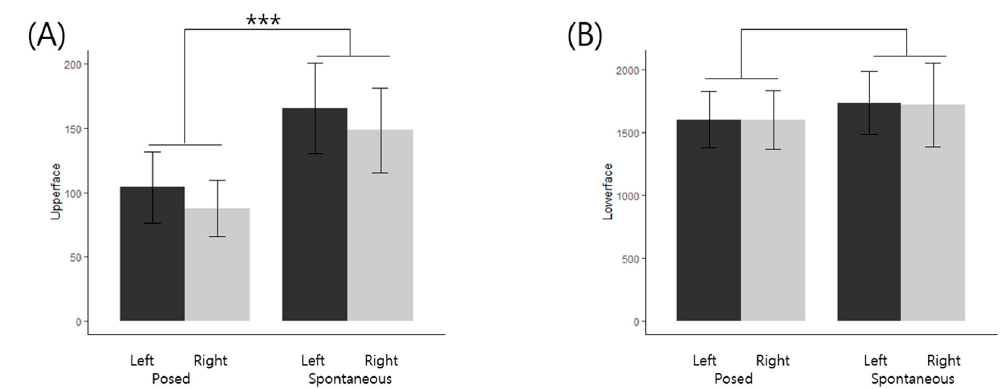
Figure 7. Classification of 3D landmarks in facial features to posed and spontaneous smiles with left and right faces. The difference in mean scores on posed/spontaneous smile intensities and left/right side of ( A ) Upper face. ( B ) Lower face. (*** P < 0.001).